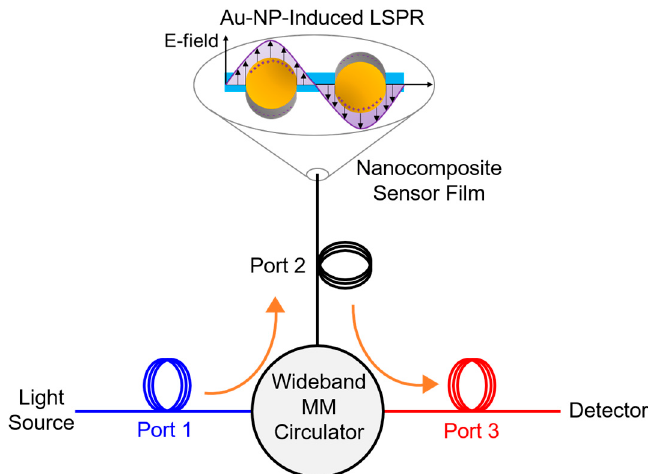
Figure 4. Optical circulator configuration of reflection-based sensor probe with fiber tip functionalized by Au-incorporated nanocomposite that shows LSPR absorption features. Conceptually, the purple arrows indicate the coherent oscillation of free electrons in Au NPs with charge separation, while the blue surface represents the oxide matrix surrounding the Au NPs.